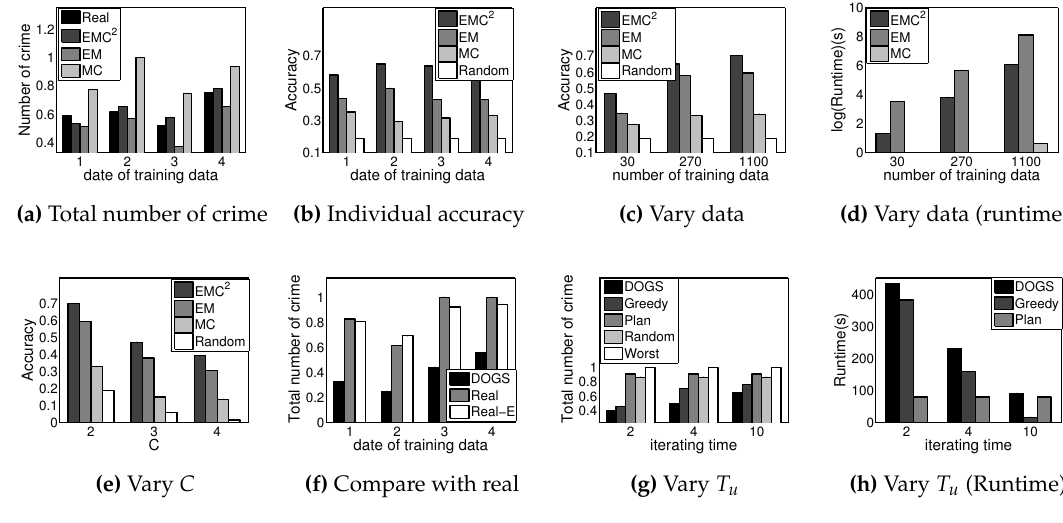
Figure 5. Experimental